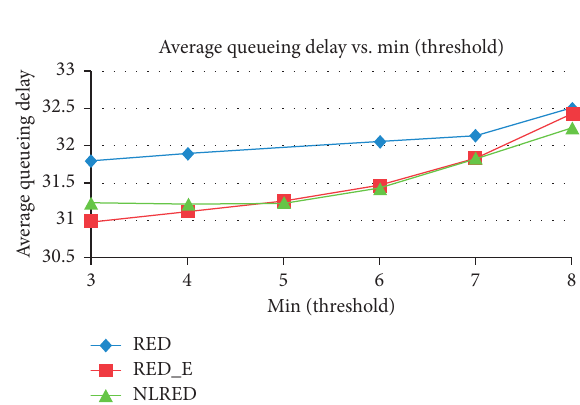
Figure 12: D versus min